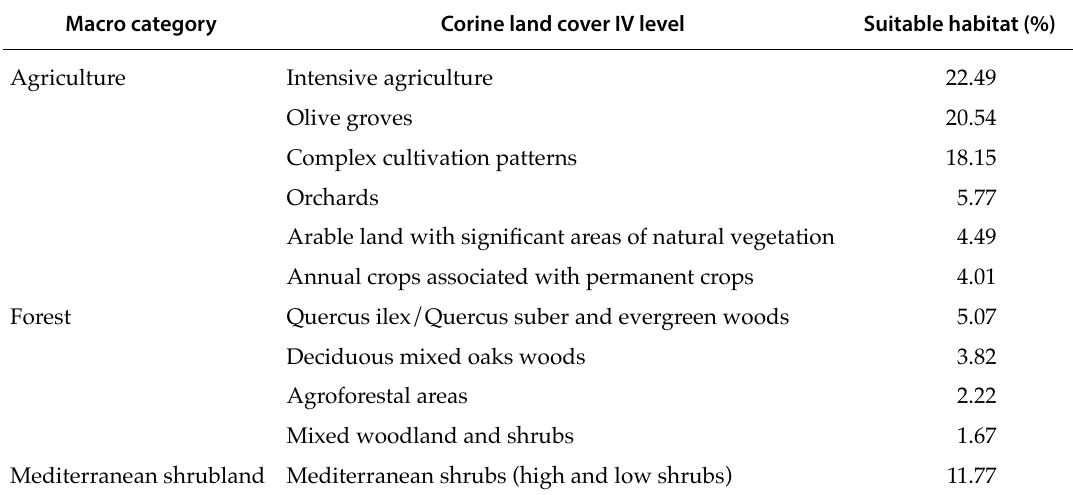
Table 4. Land use classified after Corine Land Cover 2012 IV level, according to the MaxEnt model developed for Xylella fastidiosa in